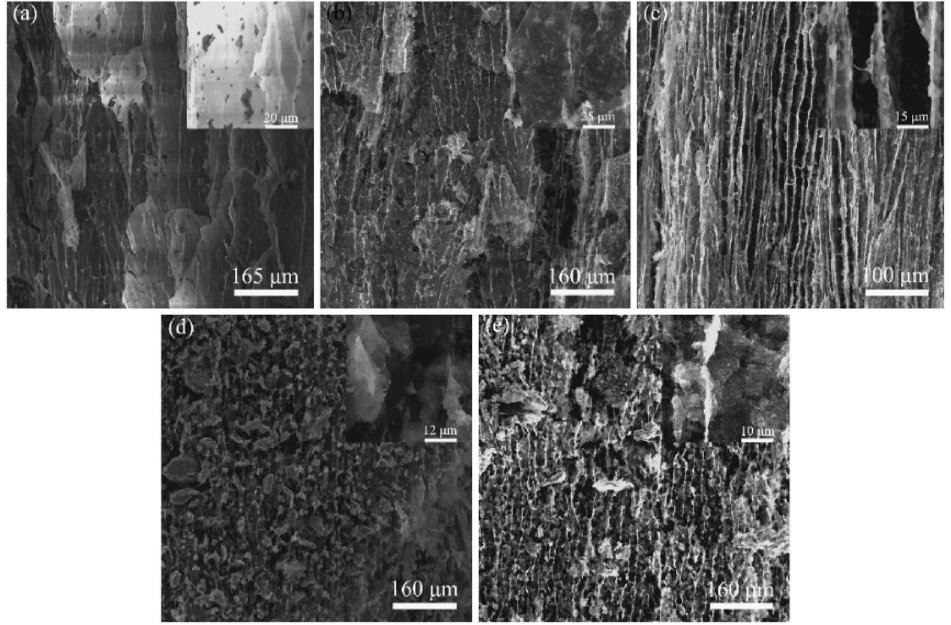
Fig. 3 SEM images of the fracture surfaces of the block with (a) 0 g, (b) 0.5 g, (c) 1.0 g, (d) 2.0 g, and (e) 3.0 g few-layer Ti 3 C 2 MXene three-dimensional